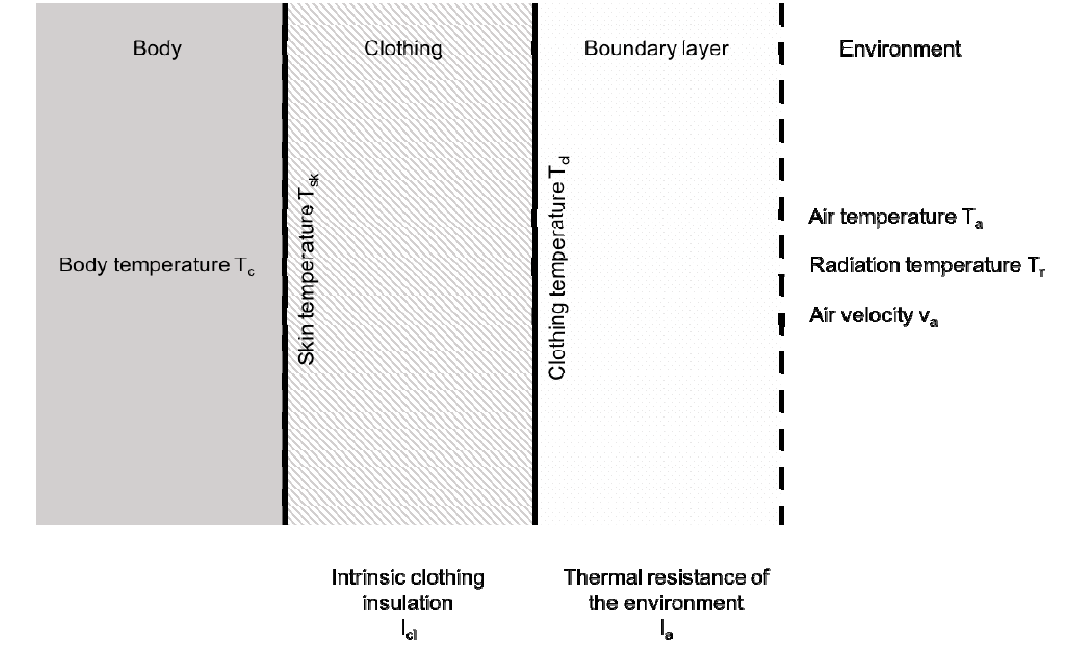
Figure 3. Simple thermal model with a layer of clothing insulation